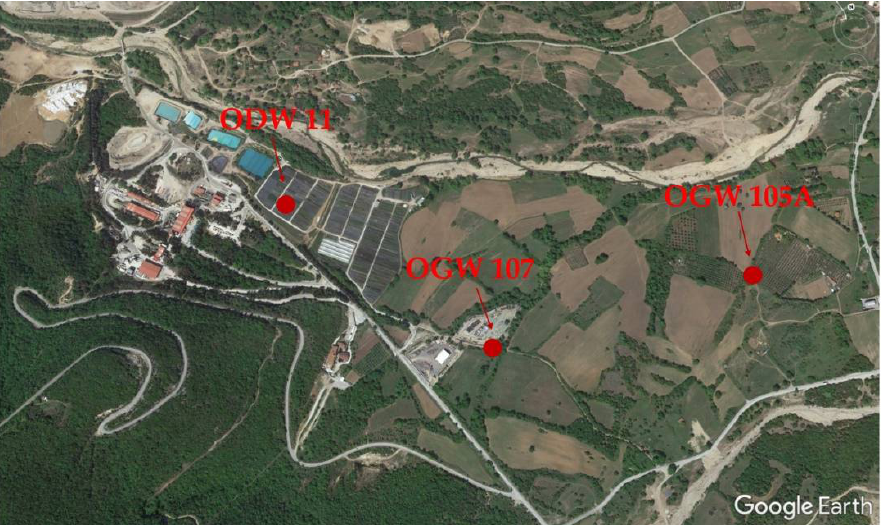
Figure 7. Monitoring of ground waters in the immediate area of the old Olympias arsenopyrites concentrate storage area (former METBA plot).